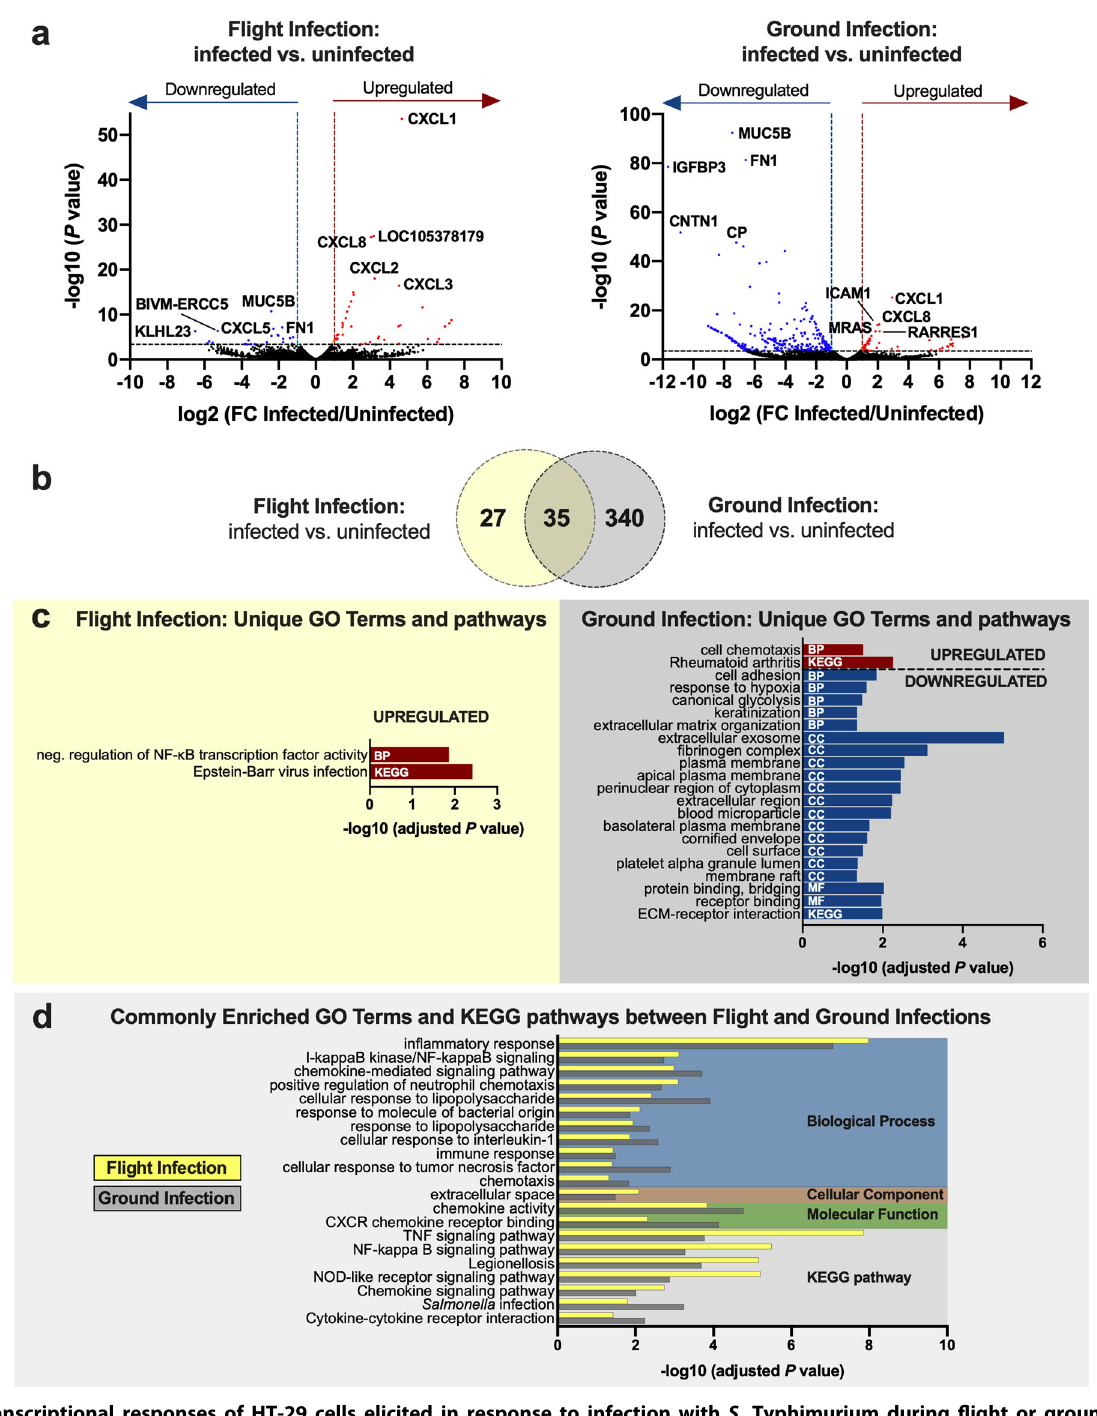
Fig. 2 Transcriptional responses of HT-29 cells elicited in response to infection with S . Typhimurium during fl ight or ground culture. a Volcano plots. Differentially expressed genes between infected and uninfected host cells during space fl ight (left panel) or in matching ground controls (right panel). Red: signi fi cantly upregulated genes in response to infection. Blue: signi fi cantly downregulated genes. Signi fi cance determined according to a log 2 fold change in expression of at least ±1 and FDR < 0.05. The top 5 signi fi cantly up and downregulated genes are labeled. b Venn diagram. Overlapping and distinct genes elicited in response to infection in fl ight and ground cultures. c , d Uniquely and commonly enriched GO terms and KEGG pathways in response to infection either in fl ight or ground cultures relative to their respective uninfected controls. Analysis was performed in DAVID 6.8 using upregulated (red) or downregulated (blue) transcripts using an EASE score of 0.05 and Benjamini – Hochberg correction to determine signi fi cantly enriched terms and pathways (adjusted P < 0.05). BP biological process, CC cellular component, MF molecular function. Bars in d indicate the results for a fl ight infection (yellow; fl ight infected/uninfected) and ground infection (gray; ground